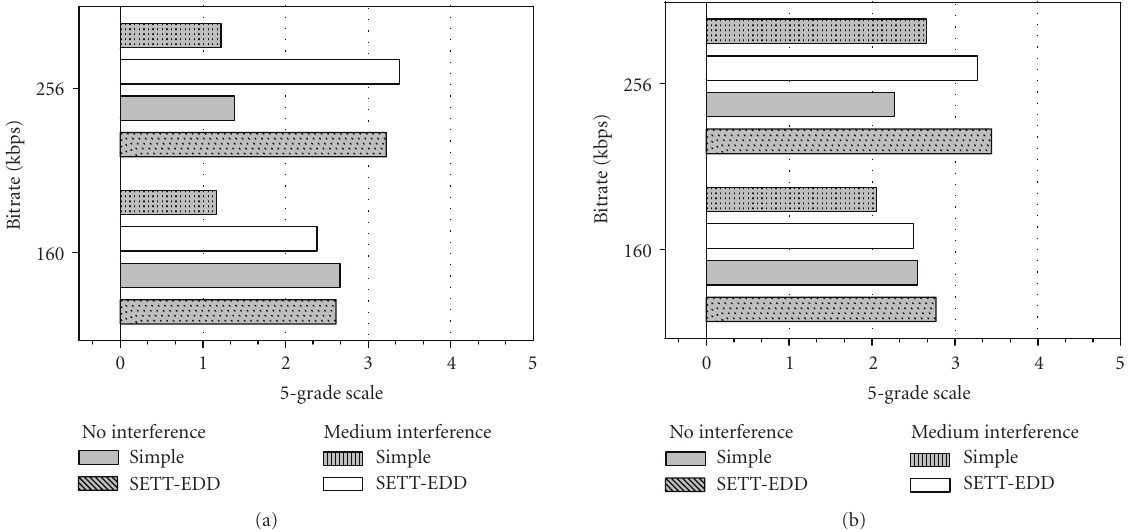
Figure 12: Subjective test results for MPEG-1 Layer III audio streaming delivery: (a) CoDeS disabled; (b) CoDeS